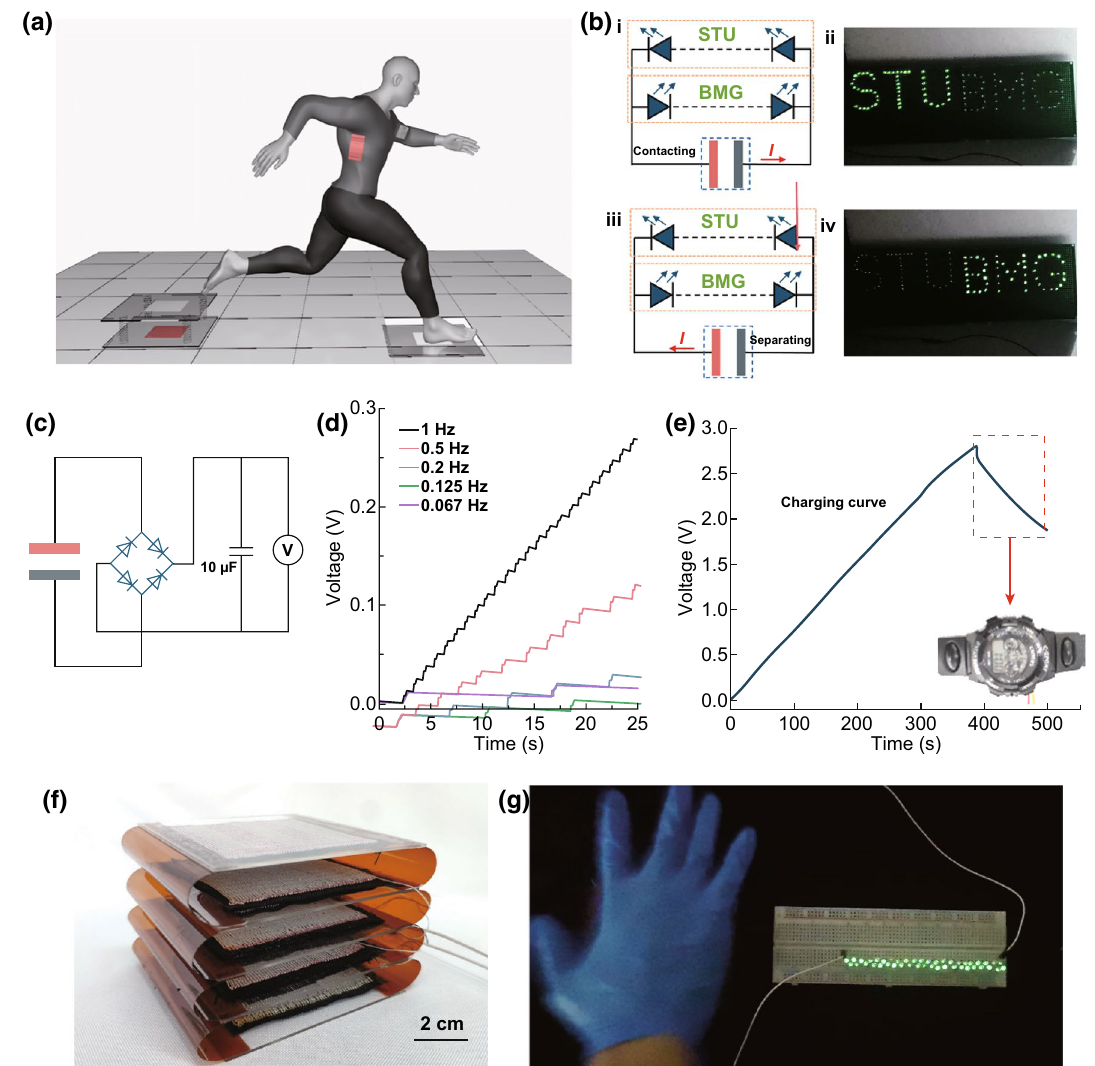
Fig. 8 Applications of EHTs: a Schematic illustration of the use of EHTs as wearable power generation fabrics and floors to harvest energy from human motion. b (i) Schematic diagram of connection between the energy harvesting floor and LEDs shaped into the letters “STU” and “BMG.” (ii) Photograph of the energy harvesting floor driving the LEDs shaped into the letters “STU.” (iii) Schematic diagram of the reversed connection between the energy harvesting floor and LEDs that make up the letters “STU” and “BMG.” (iv) Photograph of the LEDs shaped into the letters “BMG” lighted up by the reversely connected energy harvesting floor. c Circuit diagram of the energy harvesting floor to continuously charge a capacitor of 10 µF with a rectifier. d Measured voltage of a 10-µF capacitor charged by the energy harvesting floor at different frequen- cies. e Charging curve of a 100-µF capacitor charged by the energy harvesting floor at a frequency of 5 Hz. The inset shows the photograph of charged capacitor to power an electronic watch. f Photograph of multilayered EHTs with four-unit numbers connected in parallel. g Photograph of 46 green LEDs connected in parallel powered by the resulting multilayered SF/PTFEF EHTs (ambient humidity: b at 50%, d , e at 37%, and g at 65%). (Color figure